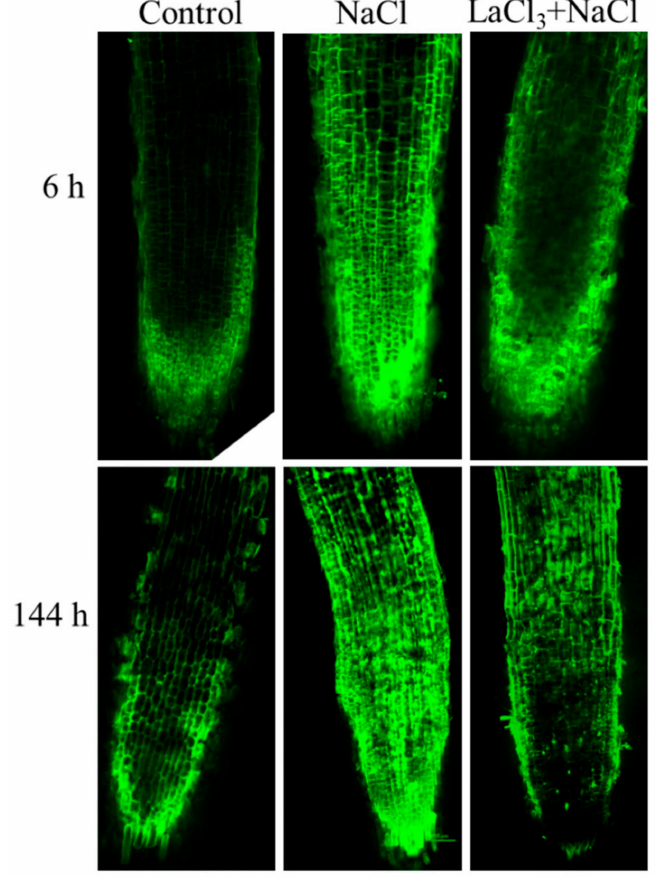
Figure 1. Confocal images of Fluo-3/AM fluorescence showing Ca 2+ accumulation in roots of wheat seedlings within NaCl treatment with or without LaCl 3